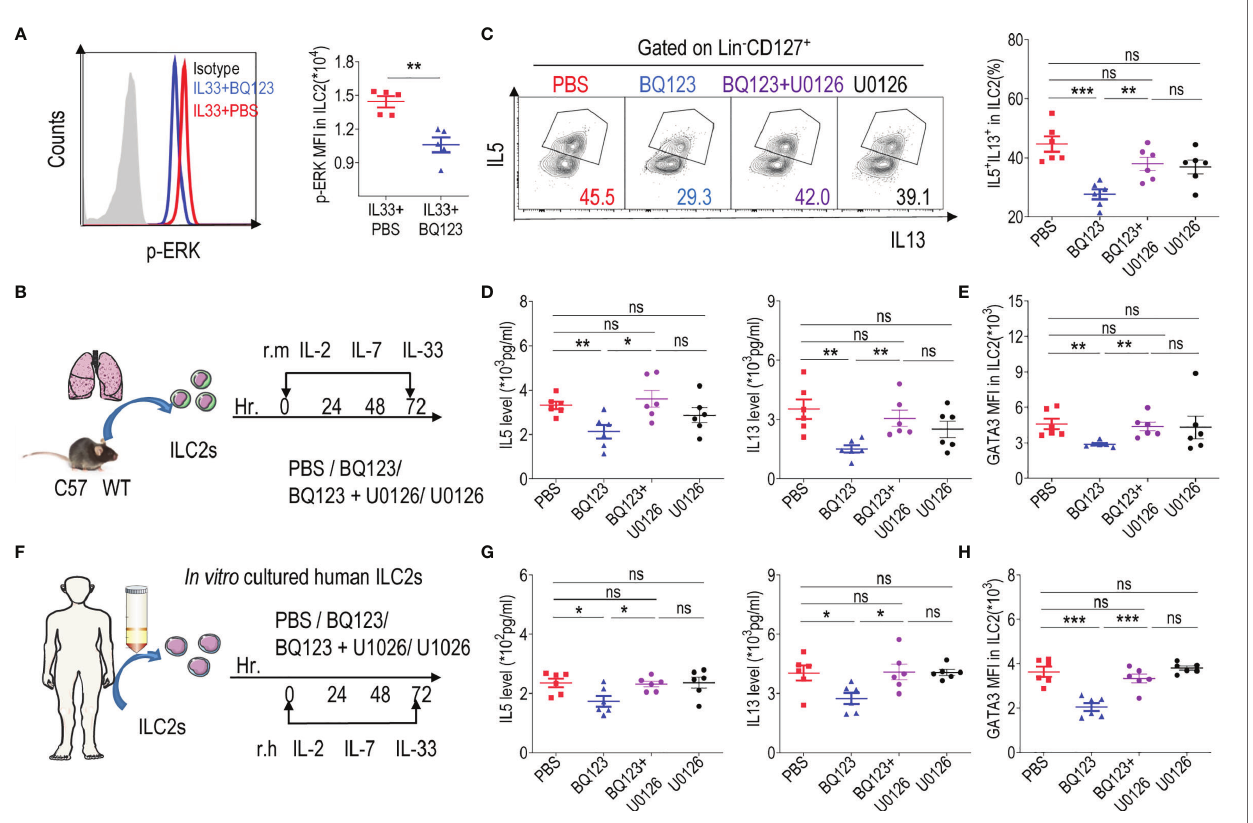
FIGURE 6 | The GATA3 levels was impaired in BQ123-mediated inhibition of ILC2s function. (A) Representative fl ow cytometry results (left) and statistical analysis (right) of phosphorylated ERK levels in lung ILC2s. (B) Puri fi ed ILC2s from mice lung were co-cultured in the presence of rmIL-2, rmIL-7, and rmIL-33 for 72 h with BQ123 and/ or the ERK inhibitor U0126. (C) Representative fl ow plots (left) and statistical results (right) of IL-5 + IL-13 + ILC2s after stimulation with PMA, ionomycin, and BFA for 4 h were shown. (F) Puri fi ed human peripheral blood ILC2s were co-cultured with 20 ng of rh IL-2, rhIL-7, and rhIL-33 for 72 h, with BQ123 or/and U0126. (D, G) Levels of IL-5 and IL-13 in co-culture supernatants were shown. (E, H) The intranuclear protein expression level of GATA3 was shown. Data are representative of two independent experiments (n = 5 – 6 for all groups). ns, not signi fi cant; *P < 0.05; **P < 0.01; ***P < 0.001. In all panels, individual results and mean ± standard error of the mean (SEM) are shown; statistical signi fi cance was determined using a two-tailed unpaired Student ’ s t-test (A – E, G, H)